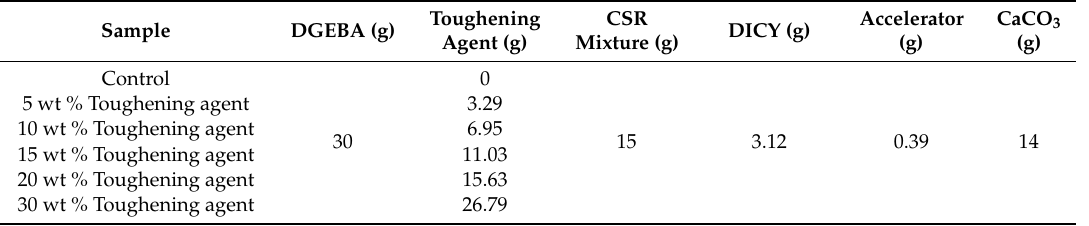
Table 2. Composition of epoxy adhesives.